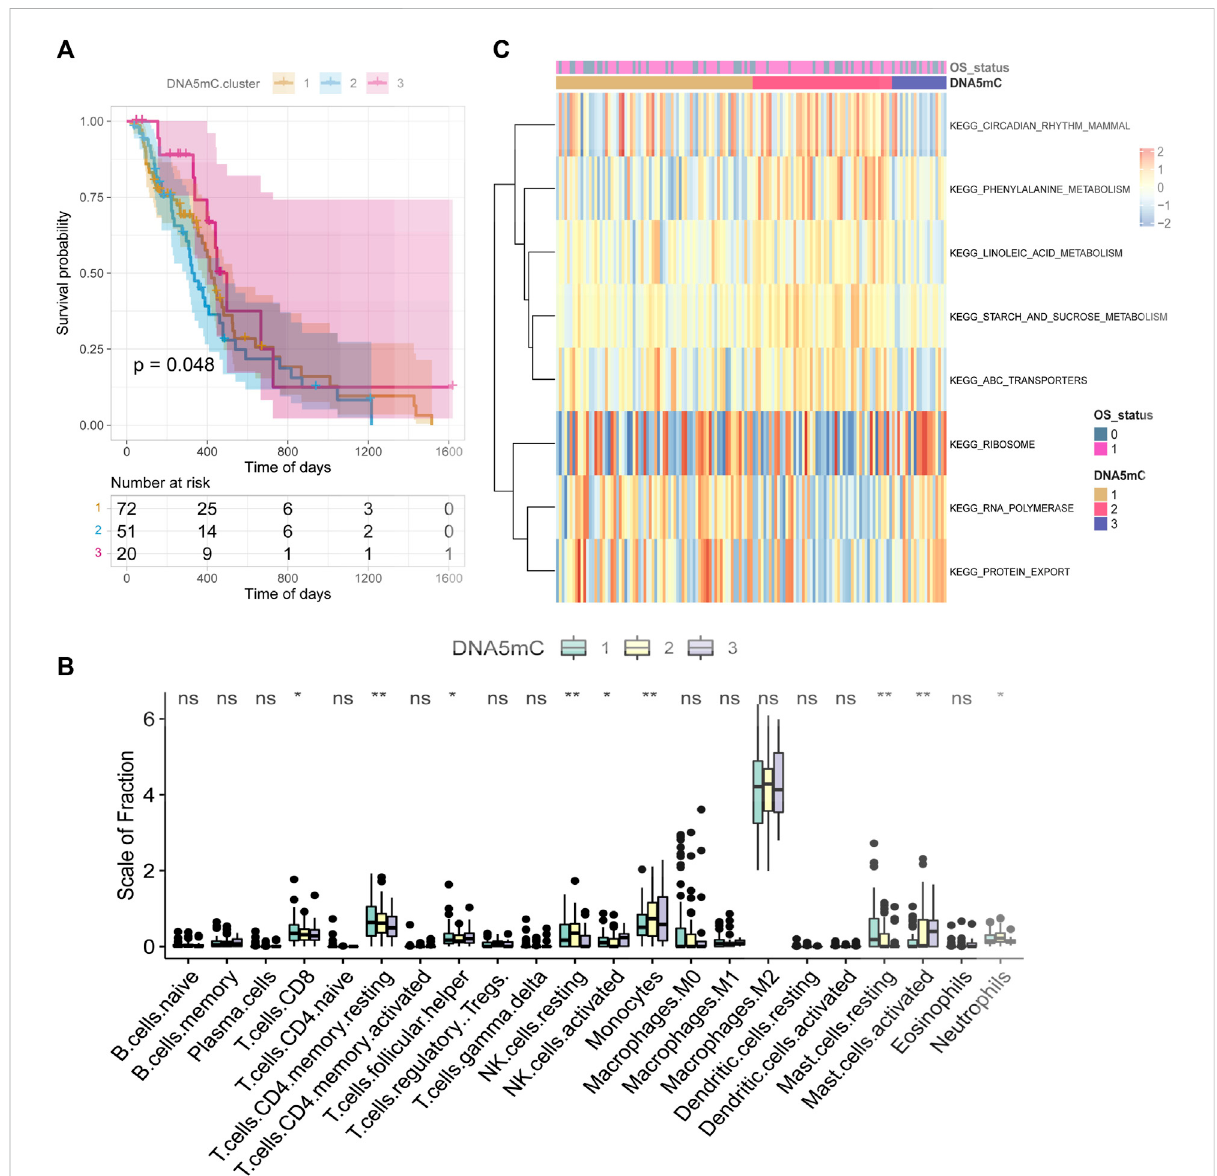
FIGURE 4 TCGA-GBM regulator identi fi cation and functional enrichment analysis. (A) Survival KM curve for tumor DNA5mC subtypes. (B) GBM DNA5mC subtypes differ in immune cell in fi ltration. (C) GSEA analysis of tumor DNA5mC groups.